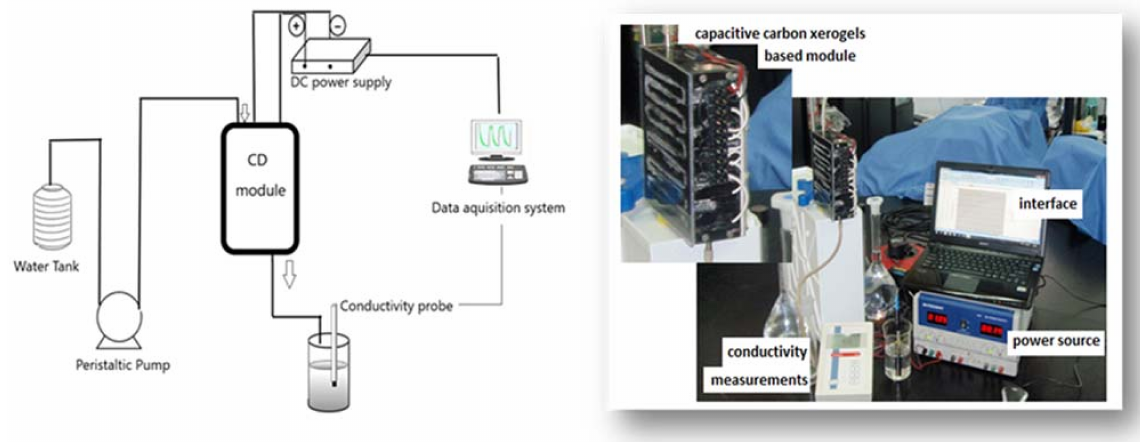
Figure 21. Schematic diagram of the experimental set-up of the laboratory CDI